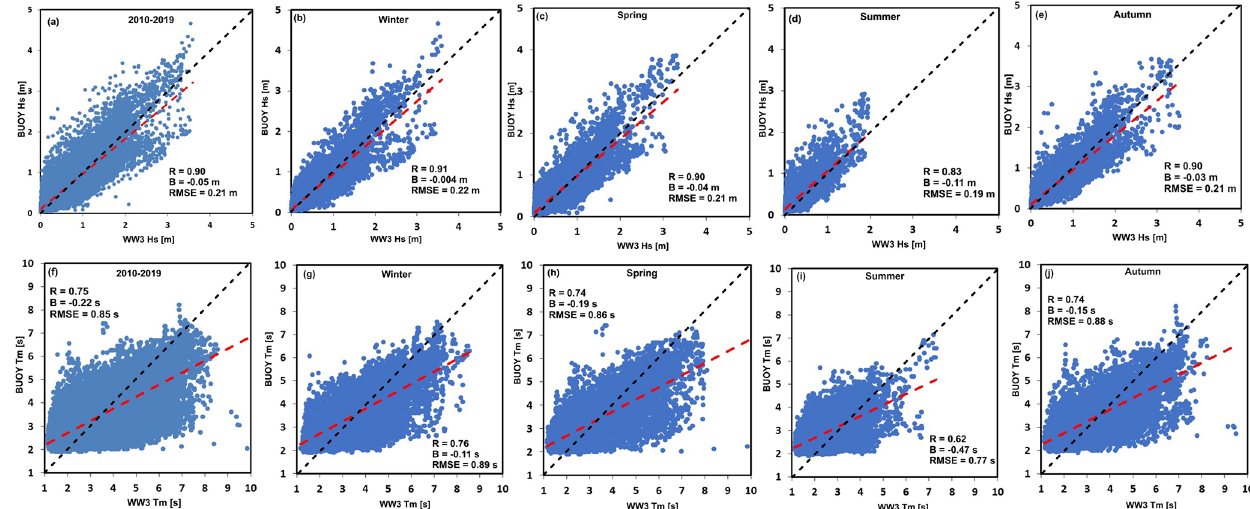
Figure 3. Observations–model scatter plot of H s (in metres) for (a) 2010–2019, (b) winter, (c) spring, (d) summer, and (e) autumn (top panels) at station 6 (Cesenatico; see Fig. 1c for location). The bottom panels show scatter plots of the mean wave period ( T m in seconds) for (f) 2010–2019, (g) winter, (h) spring, (i) summer, and (j) autumn. The dashed black line indicates the best fit (1 : 1 slope), and the dashed red line represents the data fit. ( R : correlation; B : bias; RMSE: root mean square